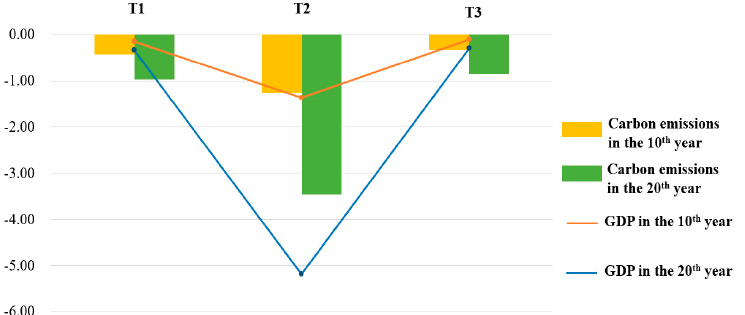
Figure 6. Impacts of the trading mechanism on GDP under scenario T1, T2, T3 in 10th year and 20th year (%).